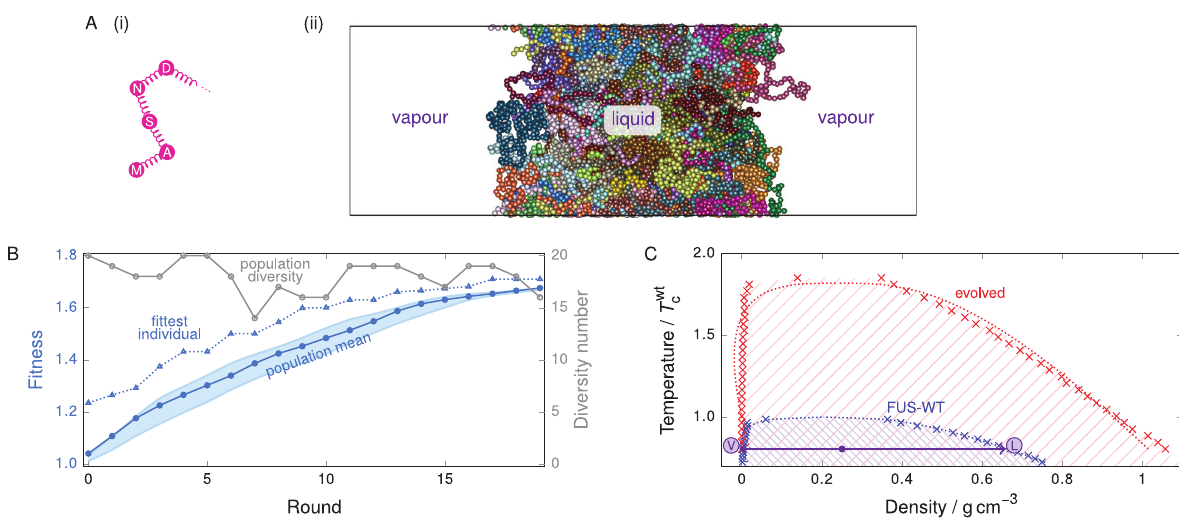
Fig 1. Evolution behaviour of FUS PLD. (A) (i) A schematic representation of the model used. Each amino acid is represented by a bead, and beads are connected with harmonic springs. (ii) A snapshot of a typical simulation cell exhibiting coexistence between a liquid-like (protein-rich, high- density) fluid and a vapour-like (protein-poor, low-density) fluid. The box is periodic in all directions. Different colours are used to represent beads in different protein chains. (B) Typical genetic-algorithm progression for FUS where the fitness function increases the width of the phase diagram. The fitness function [Eq (2)] increases by * 65% over 20 rounds. The fittest individual is 5% to 20% fitter than the mean in most rounds. The population diversity, i.e. the number of distinct sequences present in the overall population of 20, remains high throughout the run. The shaded area corresponds to the range of values of the mean fitness obtained from 3 independent genetic-algorithm runs. (C) Comparison of representative phase diagrams before and after genetic-algorithm runs, confirming that the fitness function choice was suitable. Pale hatched lines indicate the approximate region of phase separation for each case. Error bars in the density evaluations are smaller than the symbols, and dotted lines are fits as detailed in S1 Text (Sec. S1-b). The point labelled in violet corresponds to the snapshot shown in panel (A) , with the densities of the vapour-like and liquid-like fluids labelled ‘V’ and ‘L’, respectively. All densities reported are for the protein in a massless implicit solvent.